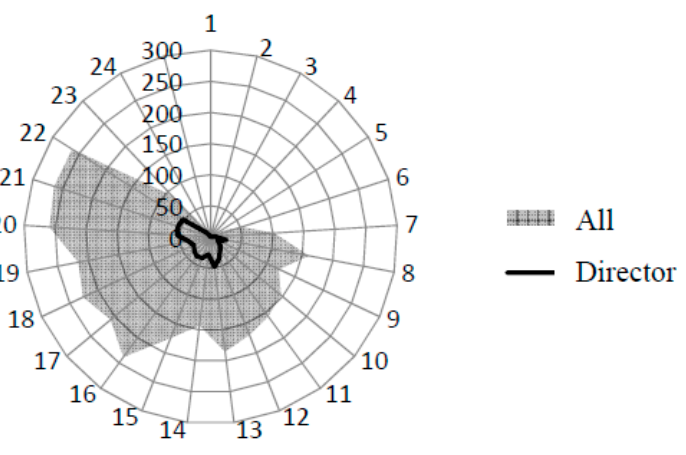
Figure 4. Daily message sending time frequency.